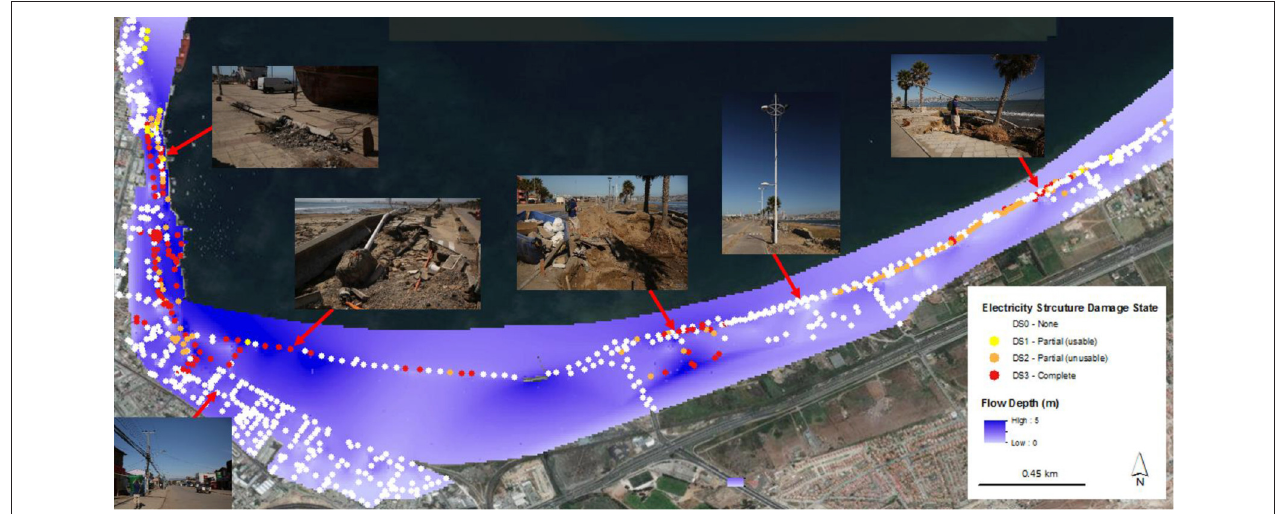
FIGURE 6 | Infrastructure damage observations: